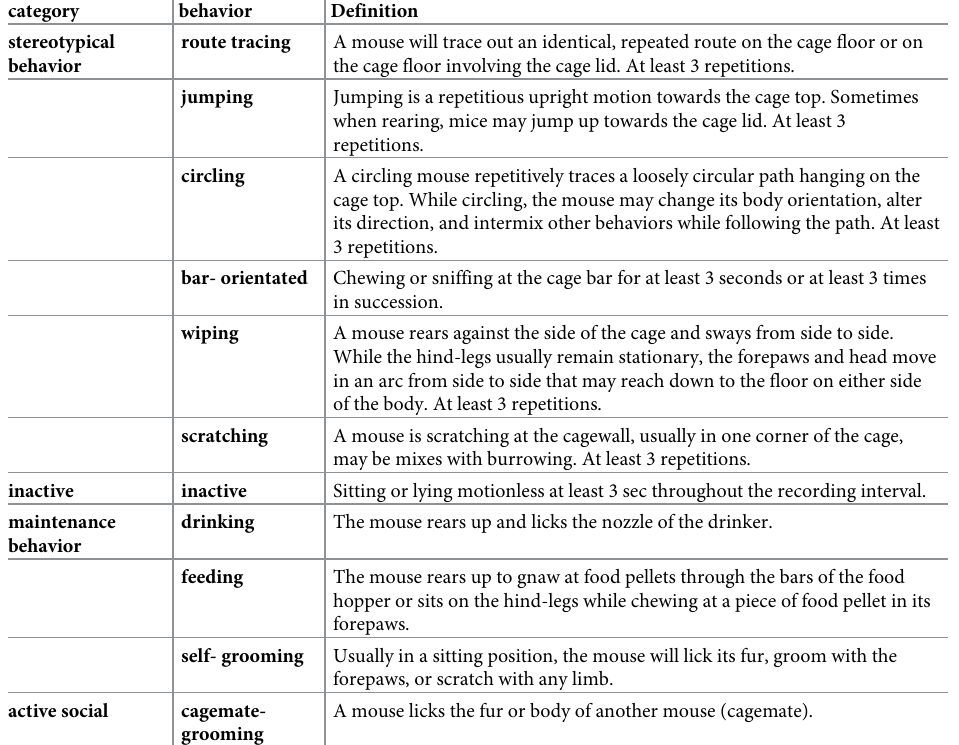
Table 1. Ethogram used for behavioral analysis in experiment